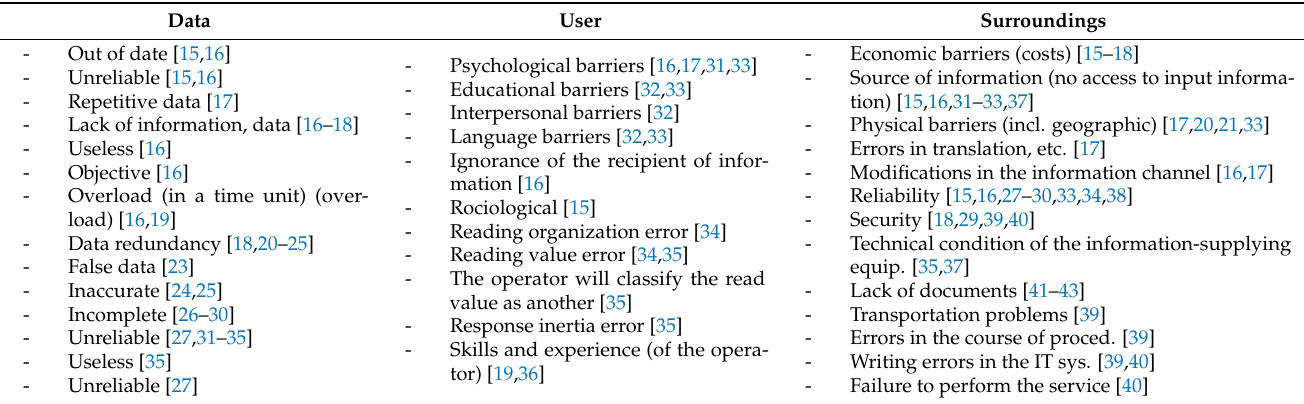
Table 1. Classification of information quality